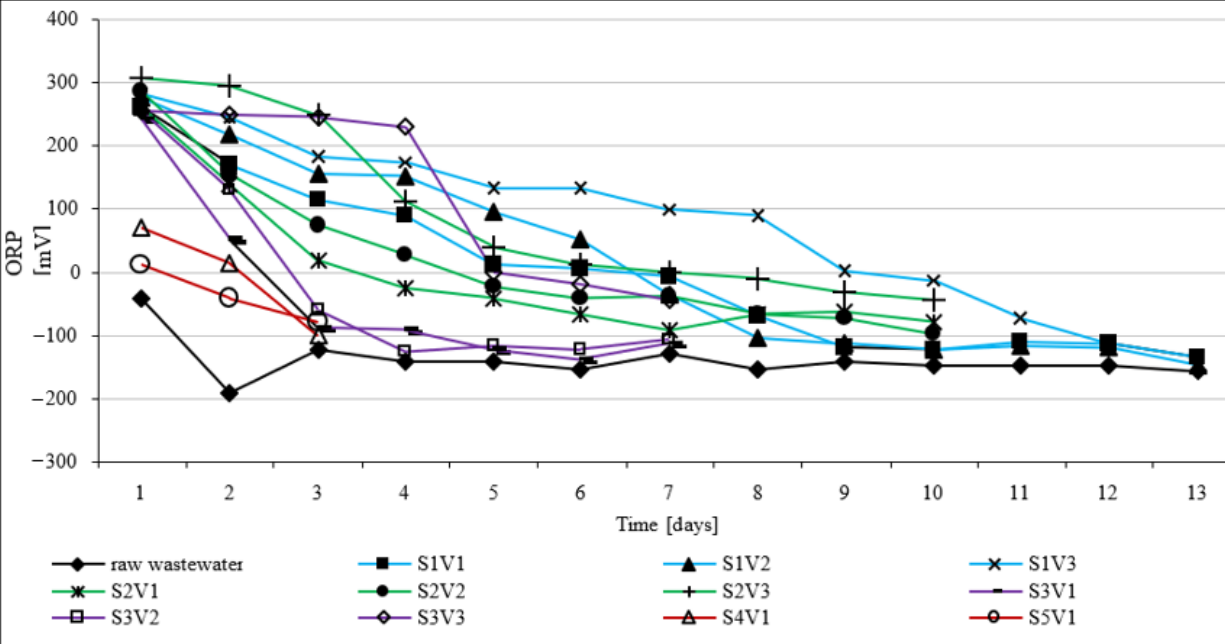
Figure 4. Changes in TOC across variants.